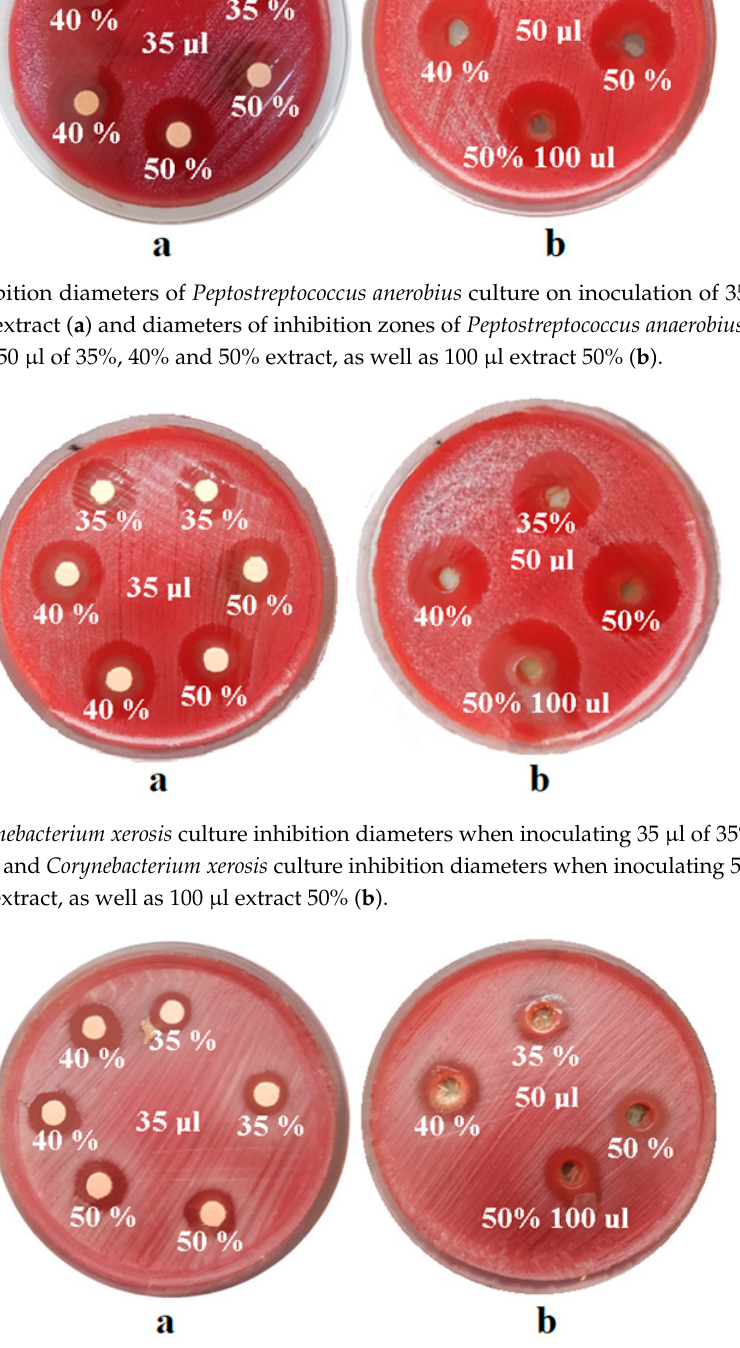
Figure 3. Streptococcus mutans culture inhibition diameters when inoculating 35 µl of 35%, 40% and 50% extract ( a ) and Streptococcus mutans culture inhibition diameters when inoculating 50 µl of 35%, 40% and 50% extract, as well as 100 µl extract 50% ( b ).